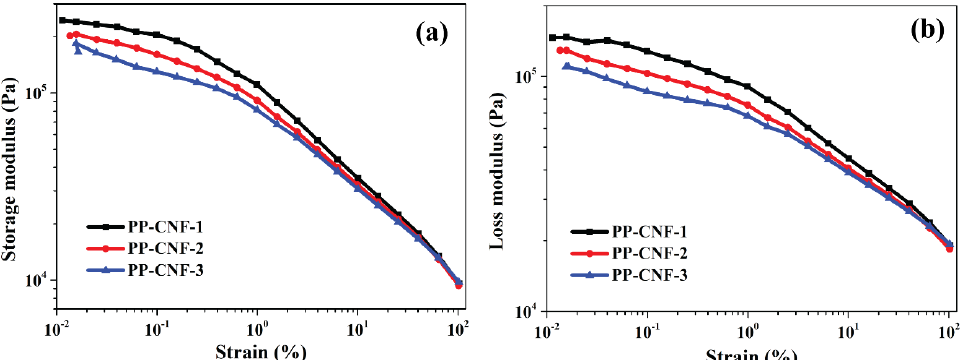
Figure 8. Stress-controlled Rheometer study of ( a ) storage modulus (G ′ ) and ( b ) loss modulus (G ″ ) of recycled PP-CNF nanocomposites with strain with varying no. of recycling at 200 °C. Variation in G ′ , G ″ , and complex viscosity ( η *) of recycled PP-CNF nanocomposite with respect to angular frequency is displayed in Figure 9. At lower frequencies, the G ′ and G ″ value of PP-CNF-1 is higher, and the value of G ′ and G ″ decreases with recycling of PP-CNF nanocomposites (Figure 9a,b). It is observed that the rate of increment of G ′ and G ″ with frequency rate is almost similar (no overlapping of the curve). It signifies the similar nature of interfacial behavior in PP-CNF nanocomposite after recycling. The value of G ′ is more than twice of G ″ , which indicates the non-terminal behavior of nanocompo-